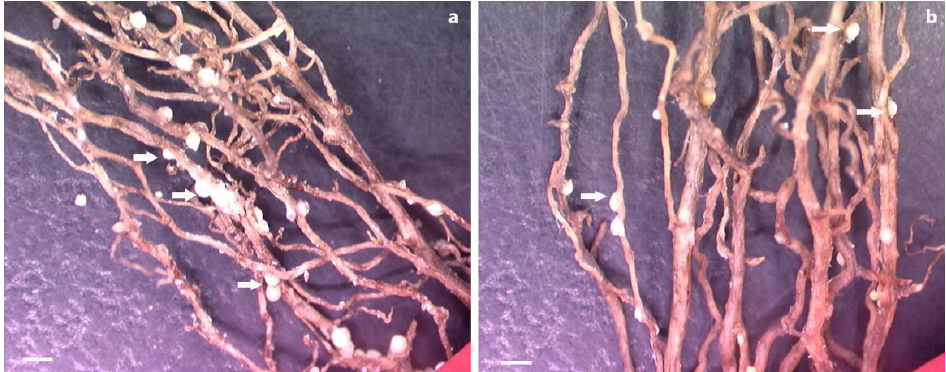
Figure 6. Roots from controls and composite plants infected with soybean cyst nematode (SCN) at 5 weeks postinoculation. ( a ) Roots transformed with pUFamiR empty construct showing numerous cysts (arrows); ( b ) roots transformed with pUFamiR–J15 showing significantly less cyst density. Scale b3ar = 1 mm.